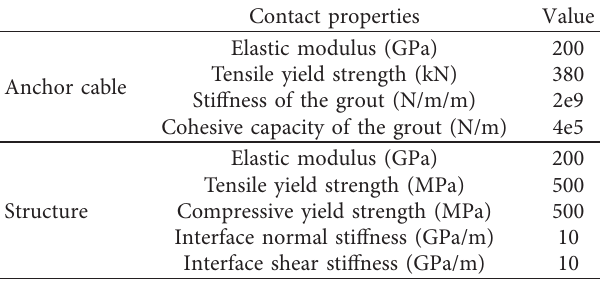
Table 4: Properties of support elements used in the model. Contact properties